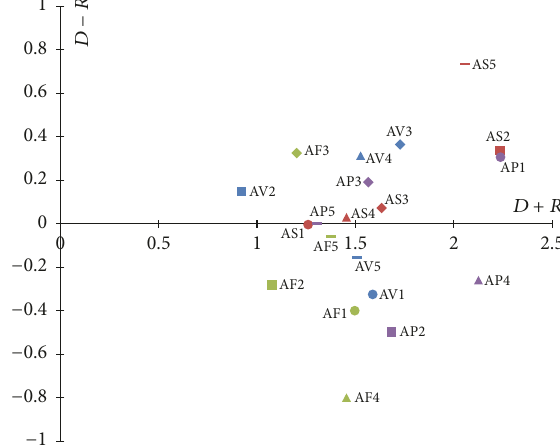
Figure 8: Cause-effect relationship diagram for Affordability (Case 2 ).